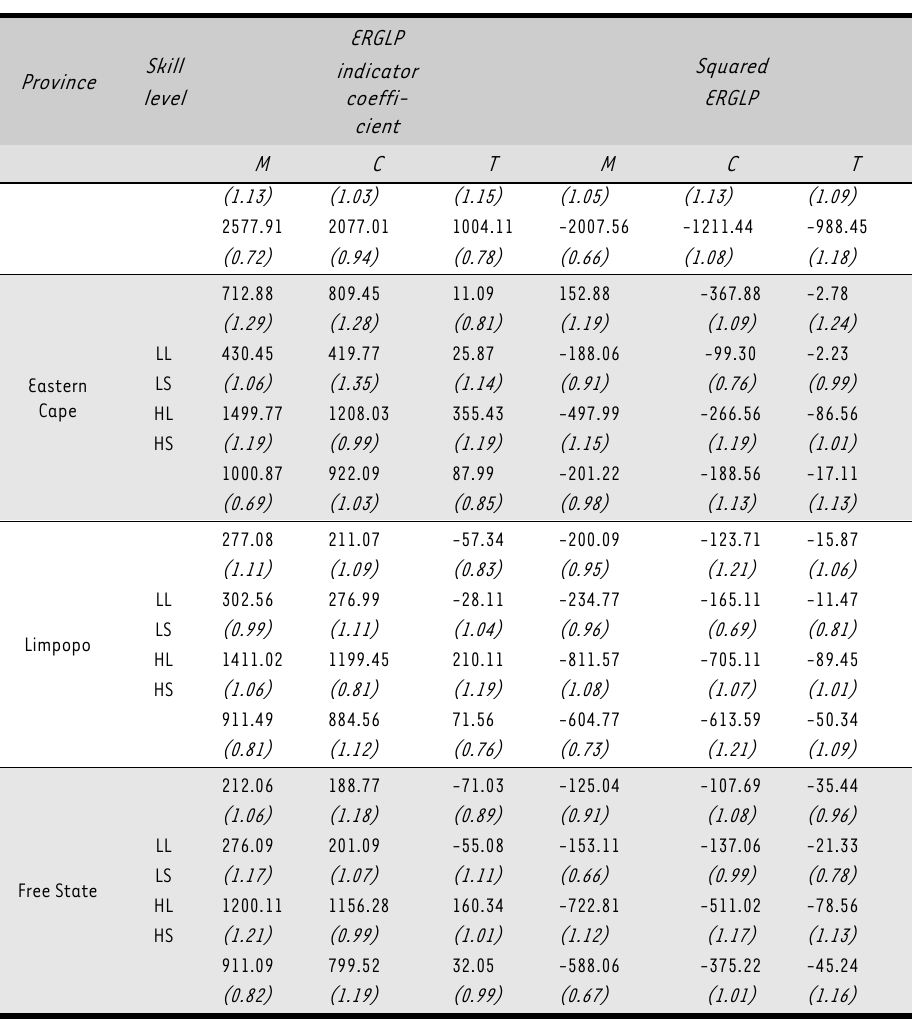
different skill categories are introduced into the estimations. It is especially small for the two lower-skilled categories in the manufacturing and construction industries of the Limpopo and Free State provinces. The fact that the ERGLP indicator coefficients are negative for the lower- skilled/large and lower-skilled/small categories of the trade and accommodation industries of these two provinces clearly indicates the non-existence of employee-remuneration gap- enhanced productivity